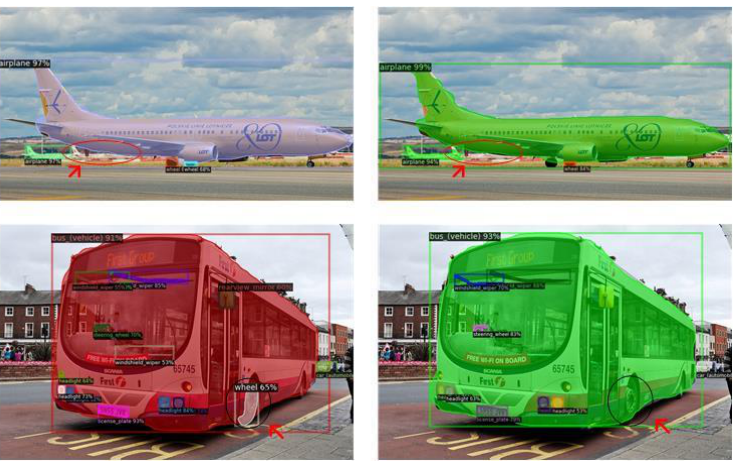
Figure 9. Limitations of the model in this paper. The left column is the label of the ground truth, and the right column is the detection result of the proposed method. The area indicated by the red arrow shows the limitations of the proposed